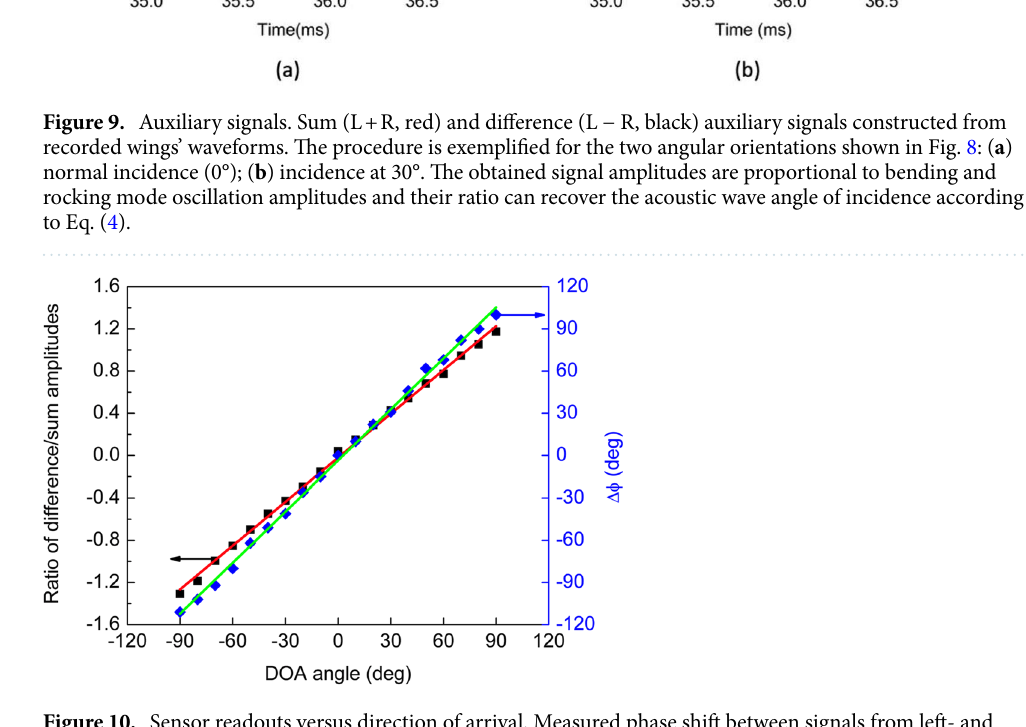
Figure 10. Sensor readouts versus direction of arrival. Measured phase shift between signals from left- and right-wings (blue diamonds) and ratio of difference over sum amplitudes (black squares) as a function of direction of sound arrival. The amplitude ratio is read on the left vertical axis while phase shift on the right. Solid lines, red and green, are the linear fittings for the ratio and phase shift,